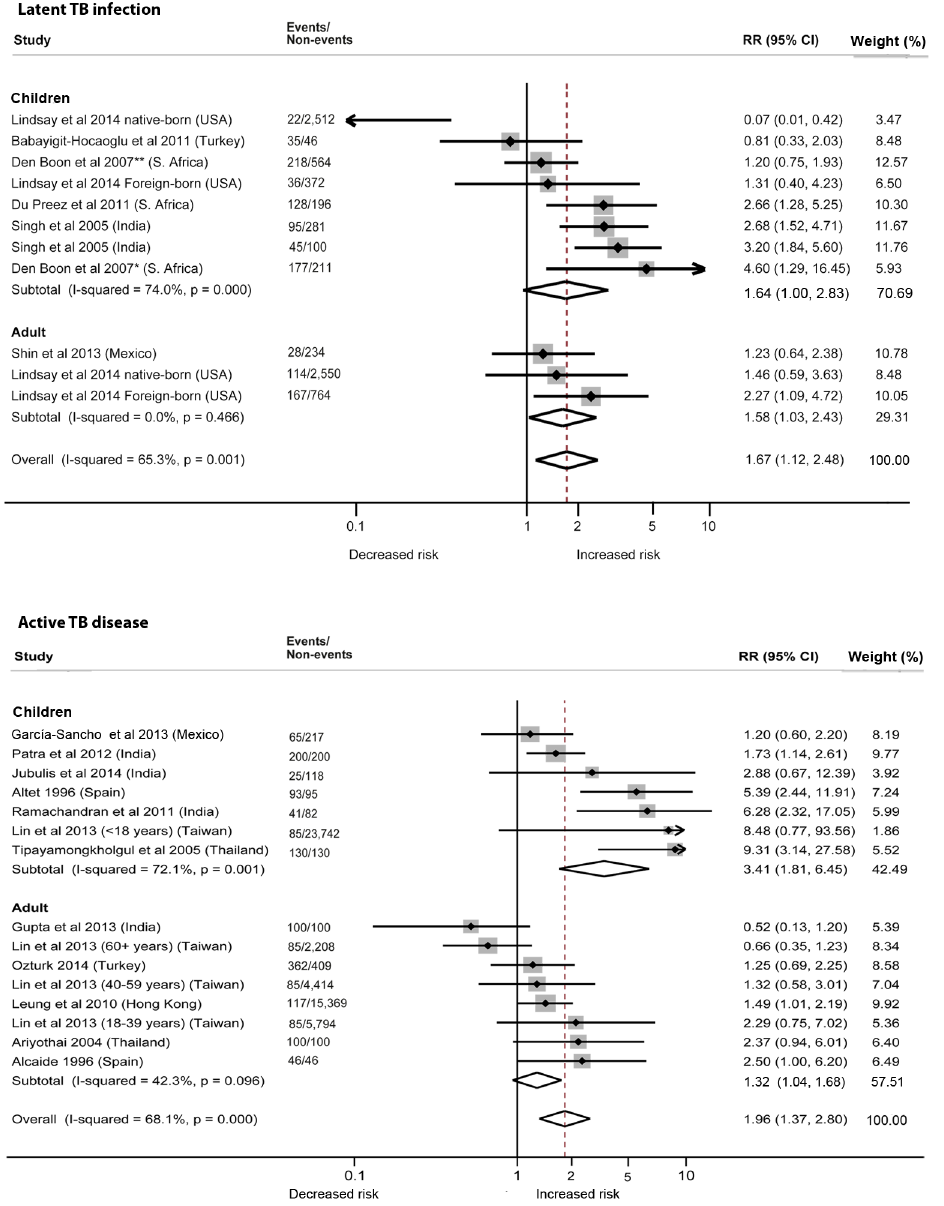
Fig 2. Risk of latent TB infection and active TB disease for second-hand smoke exposure compared to non-exposure in children and adults. (A) LTBI; (B) active TB disease. Singh et al. [24] reported SHS risks for children with contacts with sputum-negative (95/281) and sputum-positive TB patients (45/100). The effect estimate (diamond) for US-born children in the study by Lindsay et al. [22] is not displayed due to its smaller size and weight. Lin et al. [31] did not report age-stratified TB cases. Weights are from random-effects analysis. * Patient with TB living in house. ** No patient with TB living in